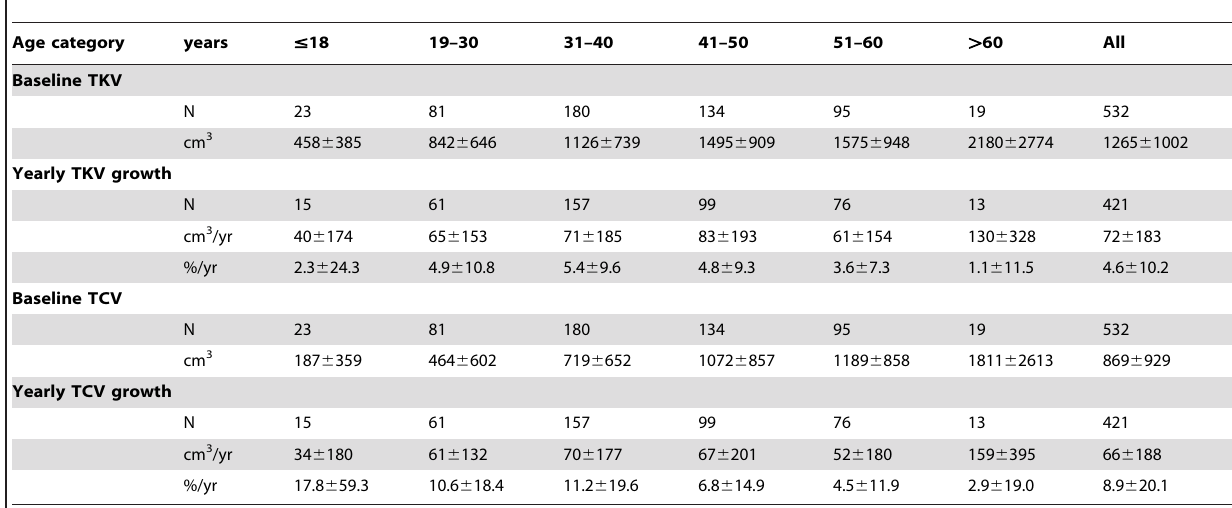
Table 3. Baseline kidney and cyst volumes and yearly volume growth rates stratified by